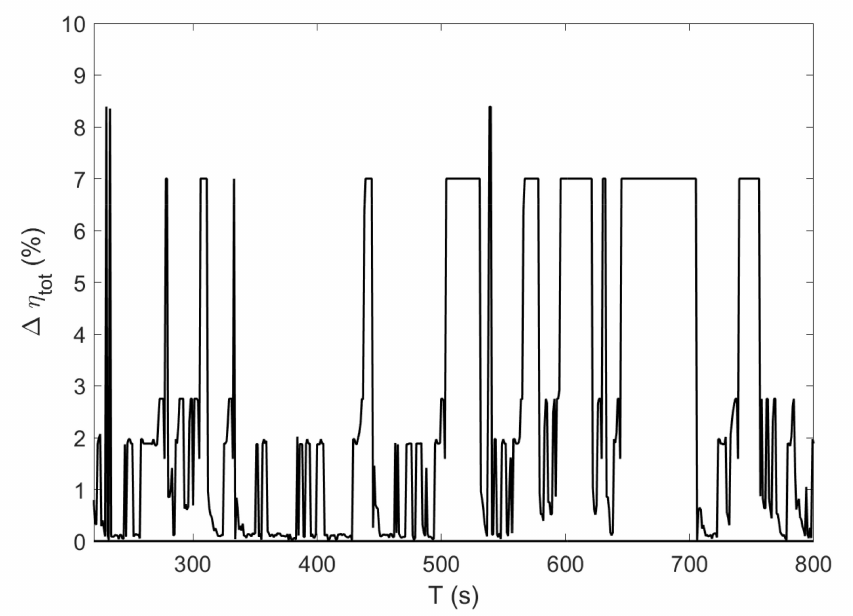
Figure 8. Relative percentage improvement in efficiency obtained by the dual-motor powertrain compared with the single-motor powertrain over the Artemis driving cycle ( ρ = 3.5, ω R,max = 0.8 ω o,max , and ω S,max = 1.7 ω omax ).